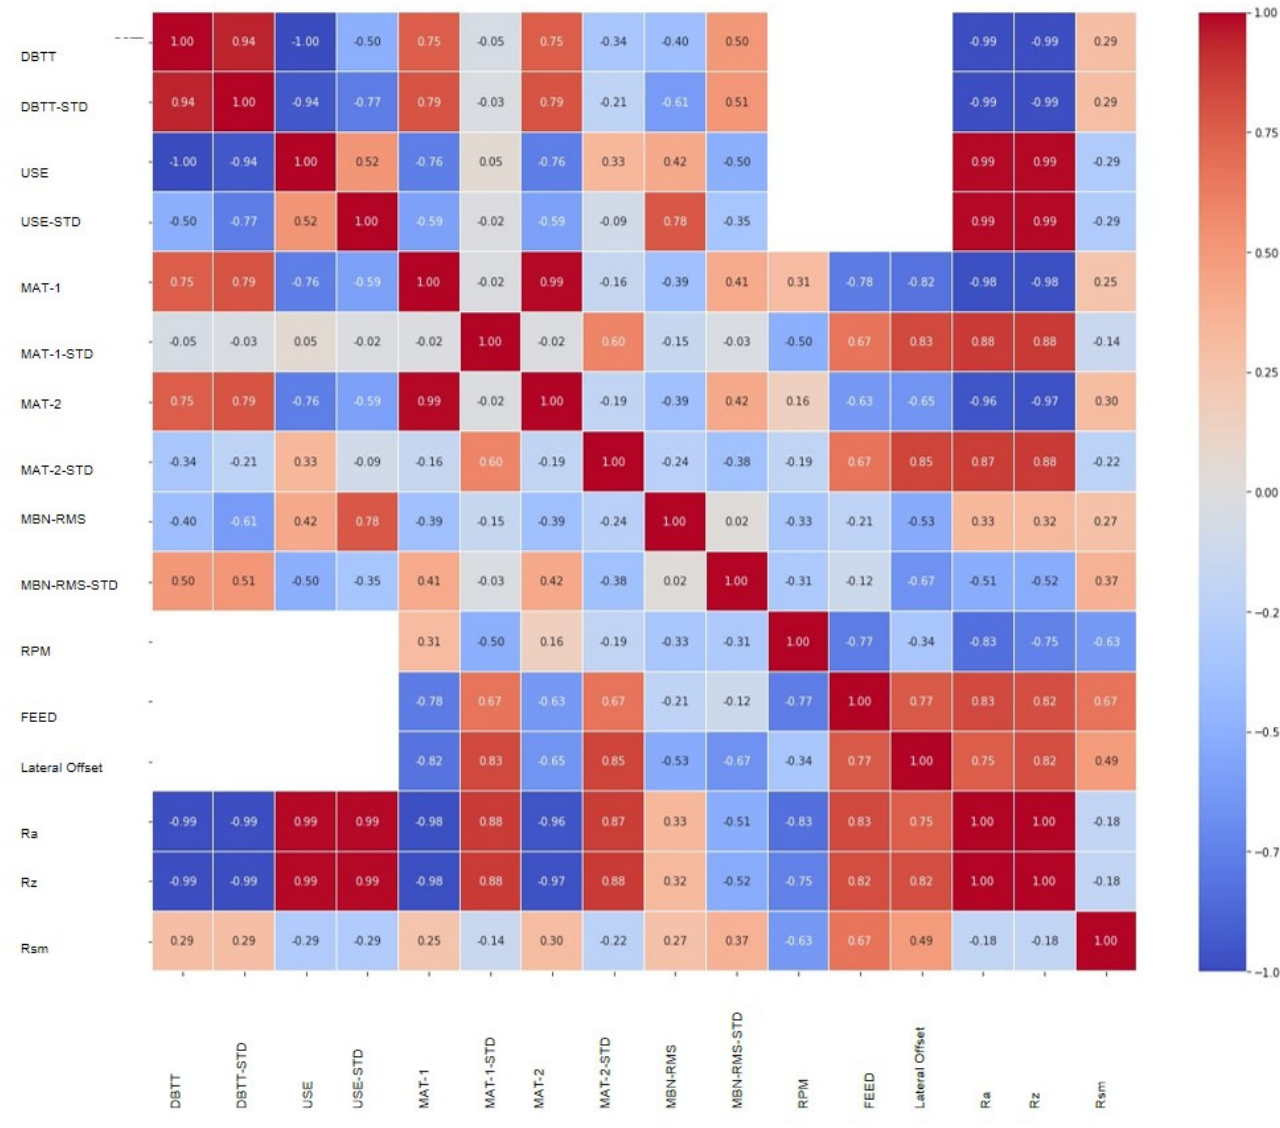
Figure 9. Round Robin Test 4 (preliminary) Correlation Heat-map.